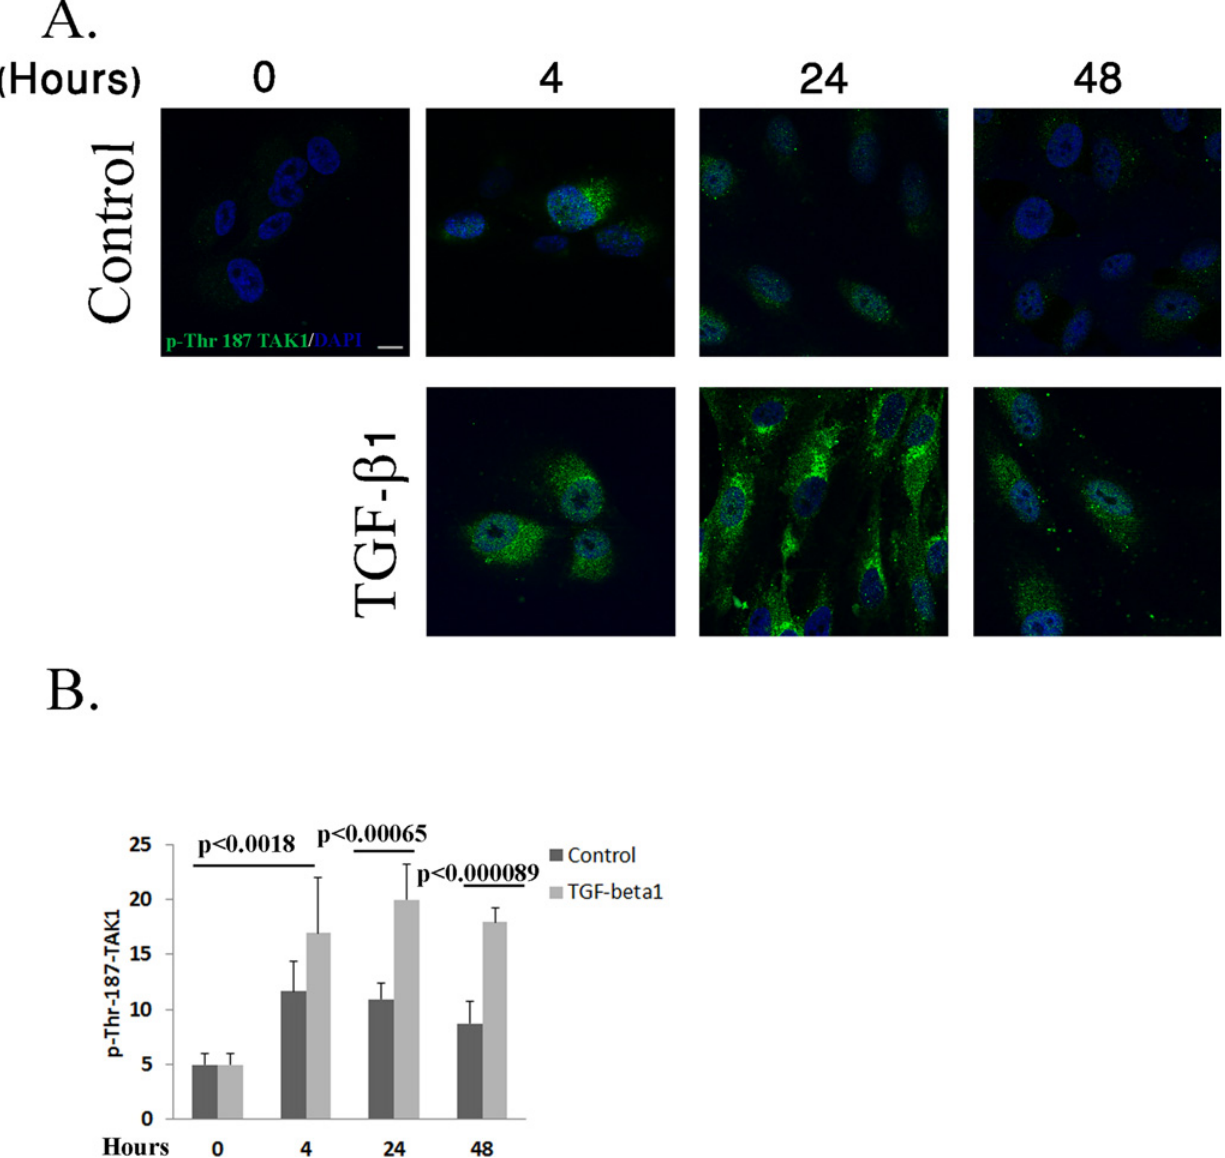
Fig 1. TAK1 is activated upon TGF- β 1 stimulation in RPE cells. A: RPE cells were treated with TGF- β 1 (2.5ng/ml) for the indicated times or left untreated. The cells were then immunostained with phospho-Thr 187 TAK1 antibodies (green) and DAPI (blue) as described in Materials and Methods. Representative photographs of three independent experiments. Scale bar is 10 μ m for all images. B : The histogram demonstrating pixel intensity, measured using Image-J software, is based on three independent experiments. (Number of cells: Control 0 = 24, Control 4 hours = 28, control 24 hours = 21, control 48 hours = 25;